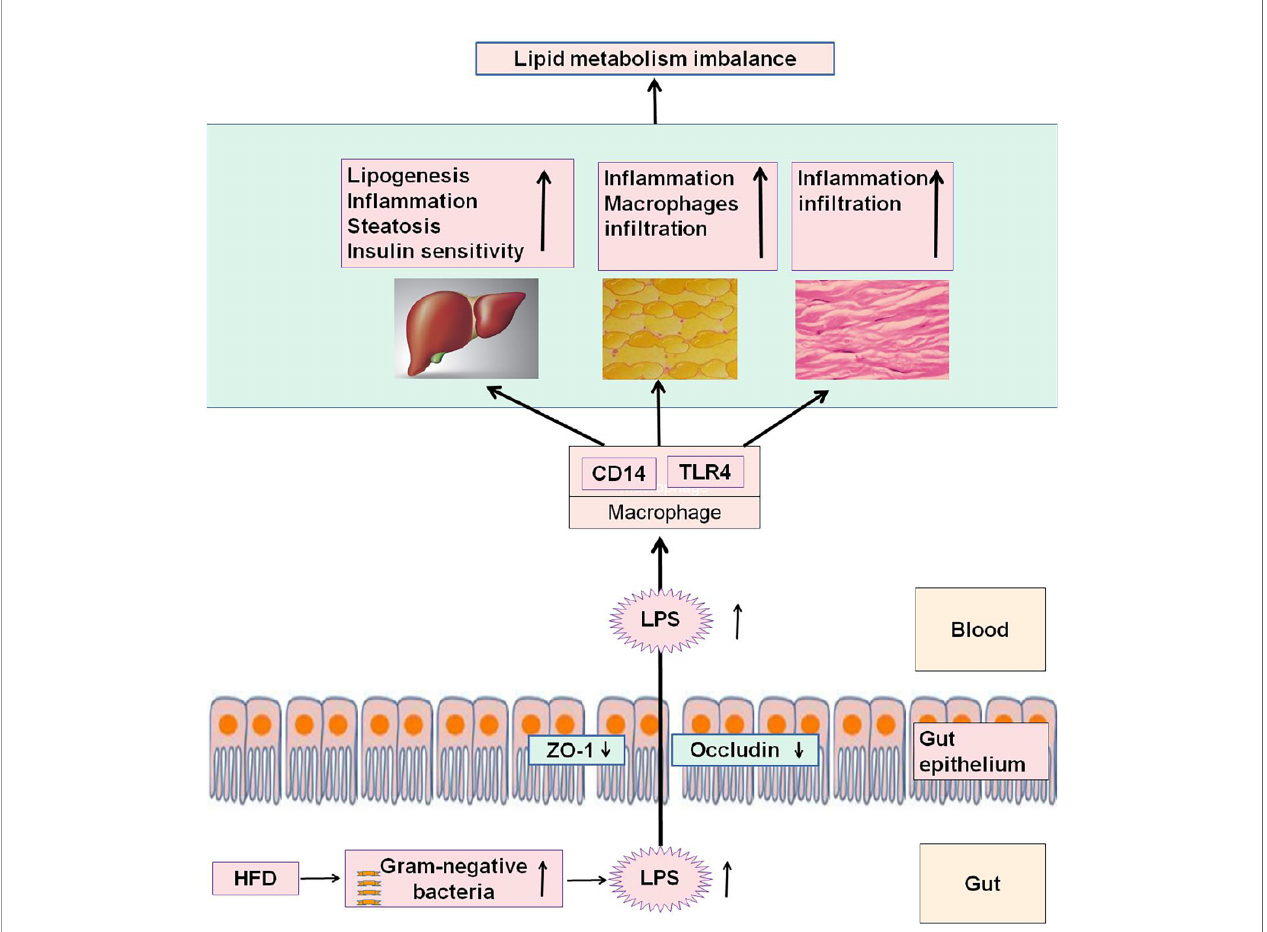
FIGURE 3 | HFD feeding changes gut microbiota, promotes metabolic endotoxemia, and triggers the development of metabolic